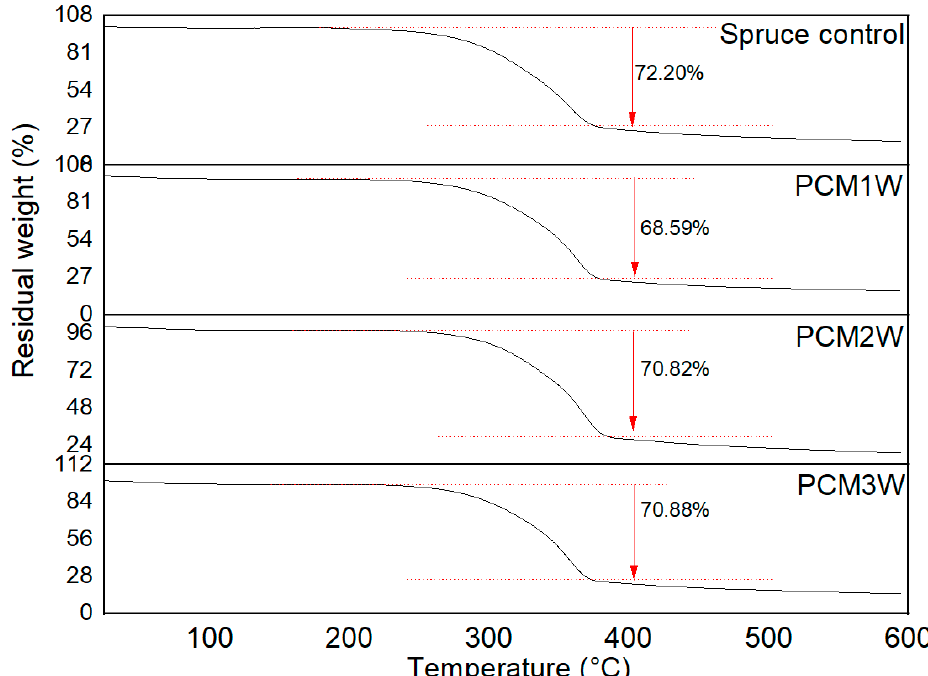
Figure 2. DTG curves of the PCM1-3.